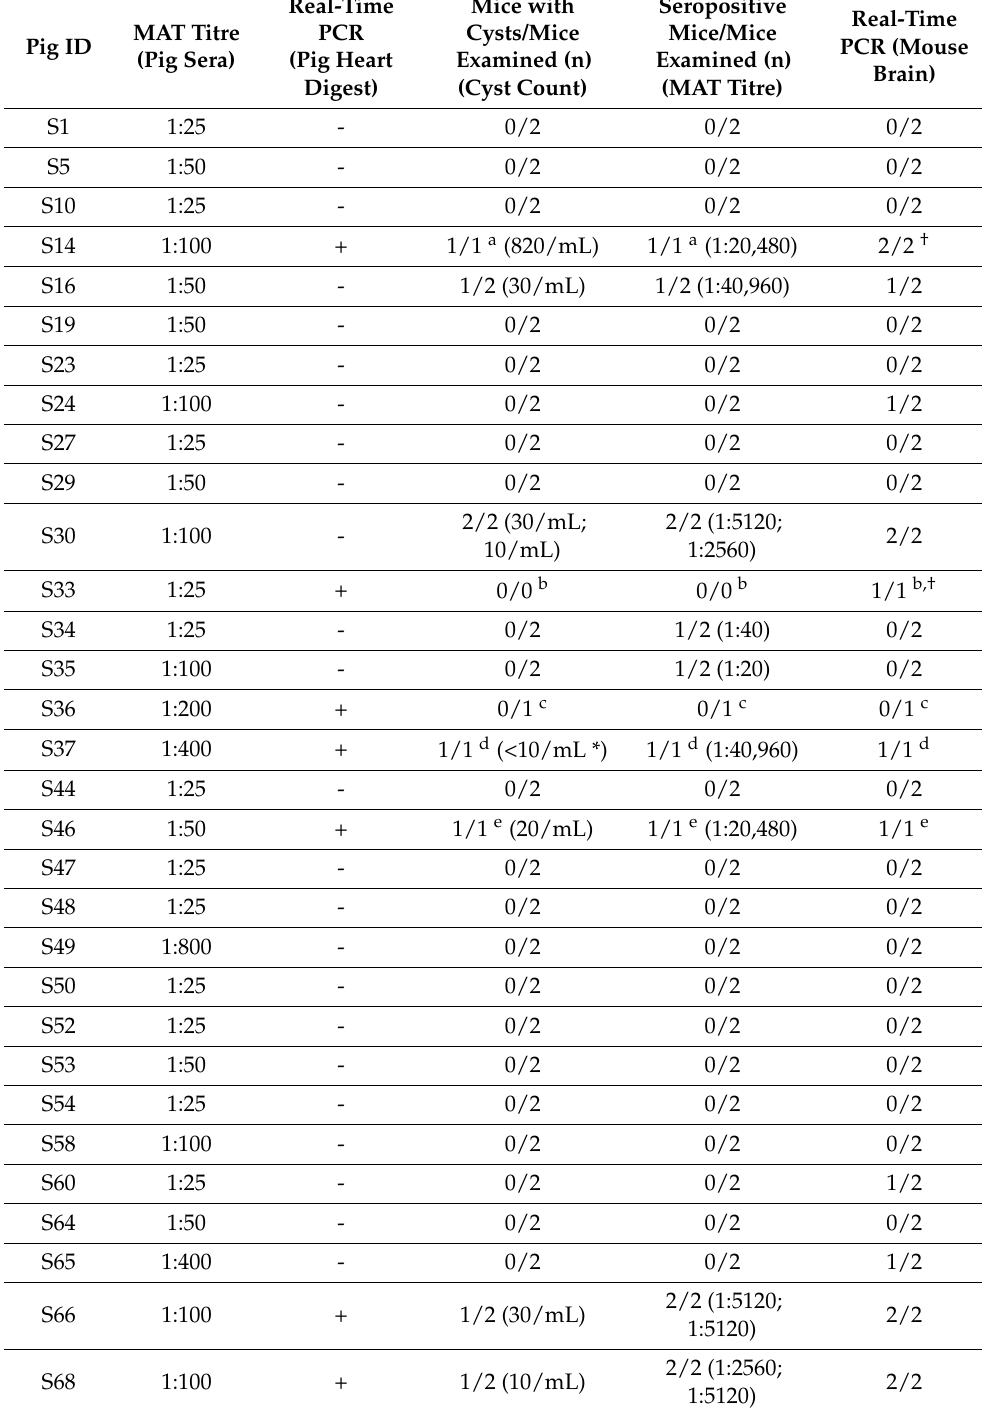
Table 4. Direct detection of Toxoplasma gondii from heart tissue of seropositive pigs. Outcome of bioassays of heart digests from 31 seropositive sows sampled at three abattoirs in Serbia. MAT Titre Pig ID (Pig Sera)